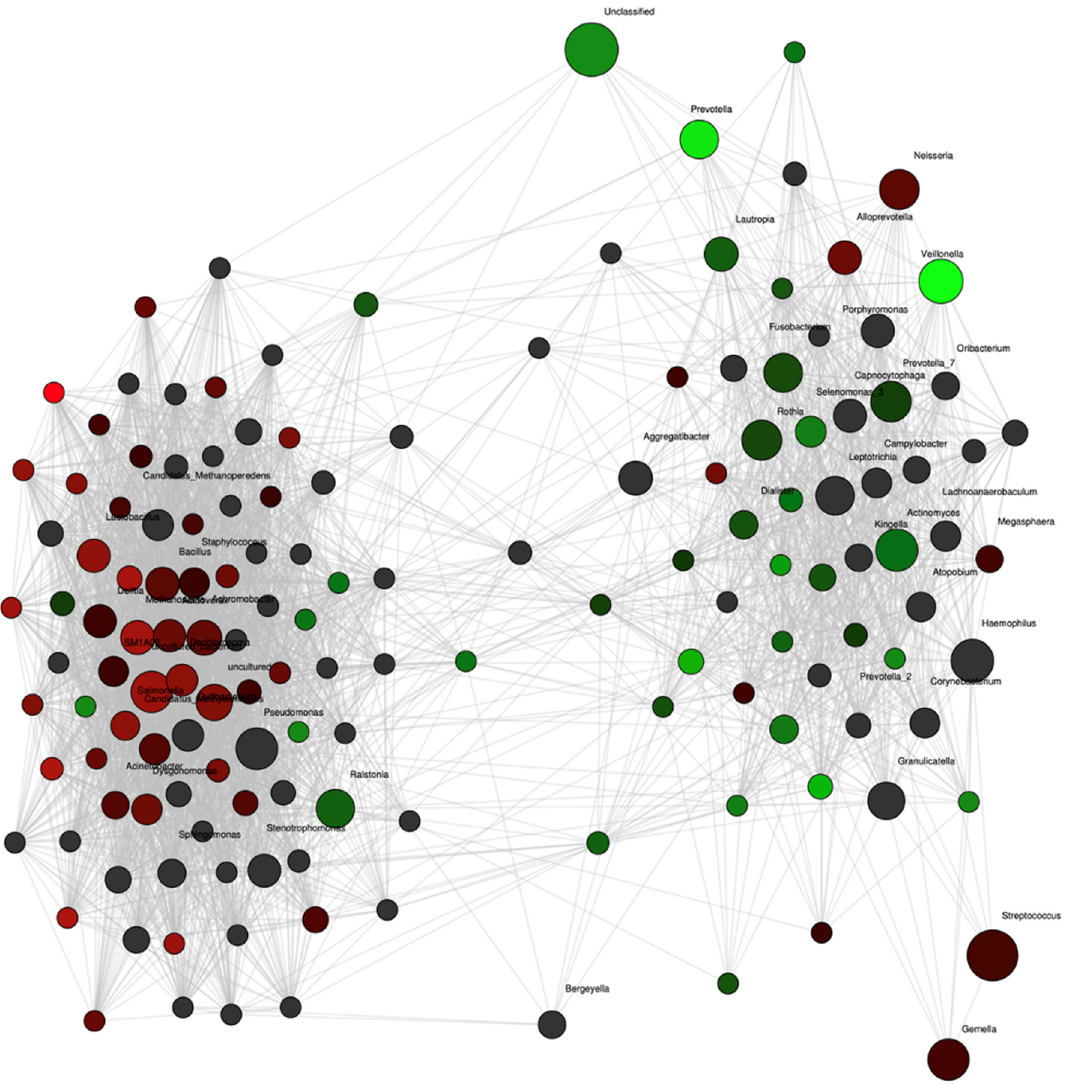
Figure 3. Network analysis at the genus level for pregnant women with preeclampsia (red nodes, n = 12) and control (green nodes, n = 24) groups at 36 weeks of pregnancy. Genera are depicted as nodes. The color intensity indicates the strength of the associations with group. Significant positive correlation coefficients were calculated and adjusted for multiple testing with 500-fold permutations.